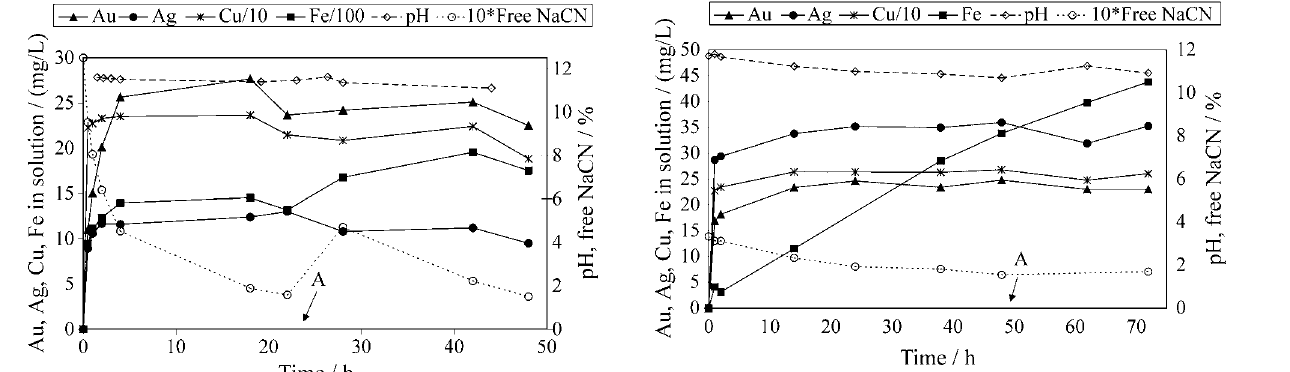
Figure 6. Product cyanidation using 0.5% NaCN solution; 1 kg of product roasted at 700 ºC, 2 L of solution, 18 g of lime; 400 mL of water and 2 g NaCN were added to the pulp at time A. Au recovery = 93.4%.